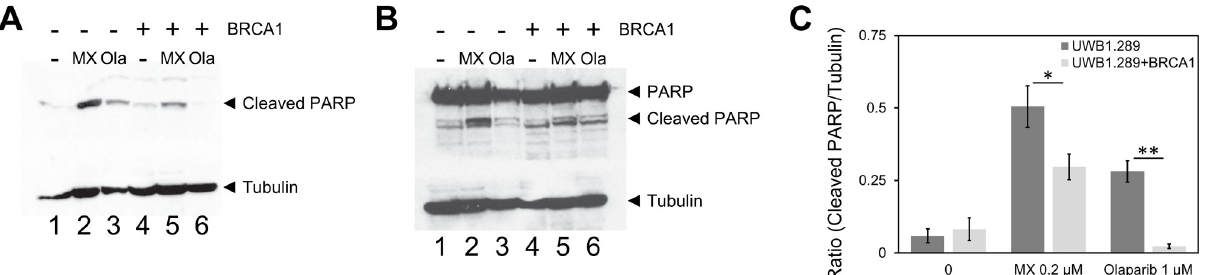
Fig 5. Mitoxantrone induces apoptosis preferentially in the BRCA1-deficient UWB1.289. UWB1.289 cells with or without restoration of the BRCA1 expression were treated with 0.2 μ M of mitoxantrone (MX) for three days. Olaparib (Ola) at 1 μ M was used as control for the induction of apoptosis. Near EC 50 concentrations were selected for each compound. After the treatment with each compound, cell lysates were prepared and cleaved PARP was detected with (A) anti-cleaved PARP antibody (Cell Signaling Technology #9541) and (B) anti-PARP antibody (Cell Signaling Technology #9542). Tubulin detected with anti-beta-tubulin antibody (Cell Signaling Technology #15115) was used as an internal control. (C) Ratios of cleaved PARP to tubulin were determined with ImageJ and graphed. Three independent experiments were performed and the mean values are shown. The bars indicate standard deviations. Statistical significance of differences was determined with Student t-test ( � p < 0.05 and �� p < 0.01).